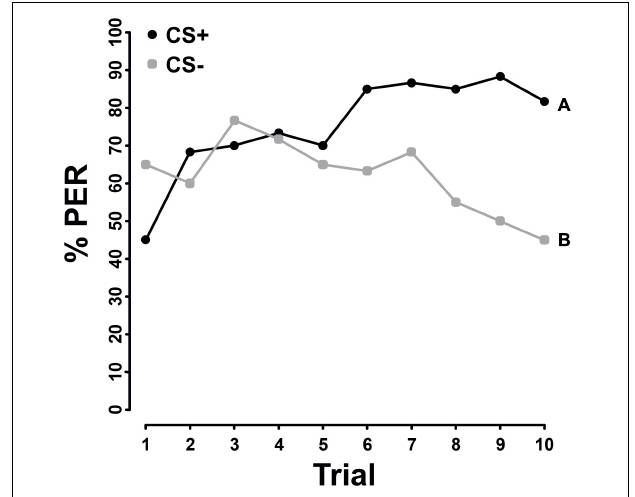
FIGURE 1 | Percentage of proboscis extension responses (% PER) shown by Apis mellifera individuals ( N = 60) in differential chemotactile conditioning to pollen enriched with 10x the natural amino acid concentration (10x AA) against pure pollen over 10 trials. CS+ (black) represents the rewarded conditioned stimulus, CS– (gray) the unrewarded conditioned stimulus. Both, 10x AA and pure pollen were used as CS+ and CS–. As there was no significant difference in learning performance between 10x AA and pure pollen used as CS+ or CS– ( Supplementary Table 4 ), data from both groups were combined. Different letters next to each line indicate a significant difference between the two stimuli ( P <